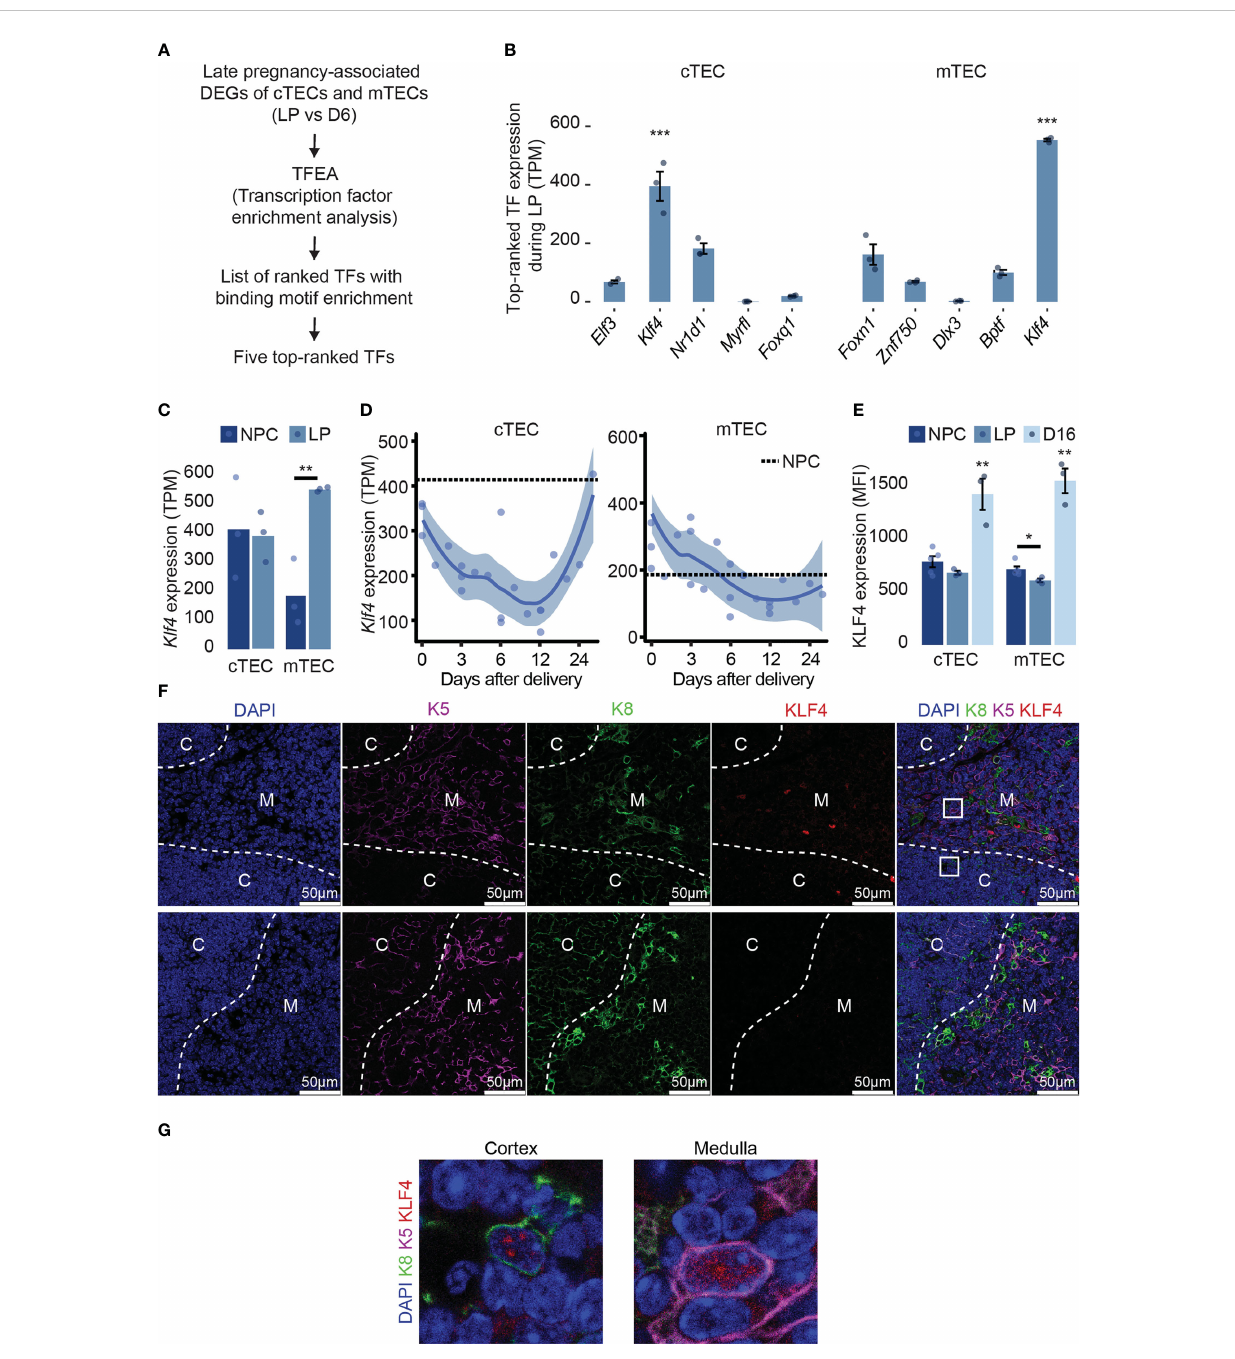
FIGURE 1 Klf4 is highly expressed and regulated in TECs. (A) Pipeline selection for identifying TFs with binding motifs enrichments among genes differentially expressed at maximal thymic involution during late pregnancy (LP) compared to day 6 (D6) post-partum in both cTECs and mTECs ( (15), GSE138494). (B) Expression of fi ve top-ranked TFs expression (TPM, transcripts per million) from TFEA analysis in both cTEC and mTEC during late pregnancy. TFs are ordered from the lowest to the highest MeanRank score on the barplot. Mean TPM was retrieved from previously published RNA- seq data (accession number GSE 138494). (C) Klf4 expression (TPM) in cTECs and mTECs from non-pregnant controls (NPC) and during late pregnancy (LP). (D) Klf4 expression (TPM) in cTECs and mTECs from delivery (D0) to D28 post-delivery. A dotted line represents NPC. (E) KLF4 expression (MFI) in cTECs and mTECs from NPC, pregnant (LP), and D16 post-partum females (D16). Signi fi cance was assessed using an unpaired two-tailed Student ’ s t -test. (* p <0.05 and ** p <0.01). (F) KLF4 immunodetection on thymus section from LOX non-pregnant females. The sections were stained with anti-K5 (magenta), anti-K8 (green), and anti-KLF4 (red) antibodies. Nuclei were stained with DAPI (blue). White arrows point to KLF4 + K5 + , KLF4 + K8 + , or KLF4 + K8 + K5 + cells. Images are representative of three mice and were taken using a ×40 objective. The bottom line shows control images obtained by replacing the anti-KLF4 antibody with the corresponding isotype. Dotted white lines delineate cortical (C) , the cortico- medullar junction (CMJ), and medullary (M) regions; scale bars, 50 m m. (G) Enlarged boxed areas from the cortex and the medulla display the nuclear localization of KLF4 in cTECs and mTECs. Images were taken with a 63x